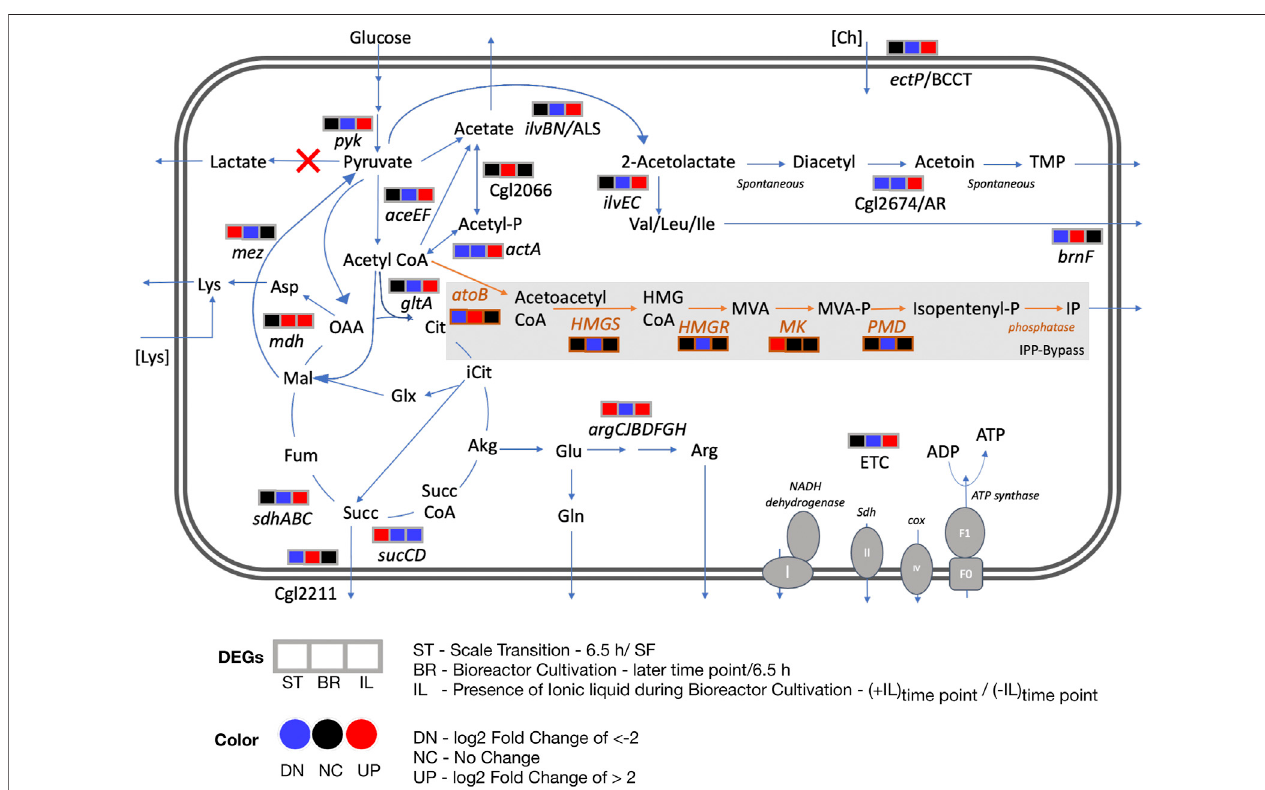
FIGURE 6 | Differential transcript pro fi les of engineered C. glutamicum under fed-batch cultivation. Three DEGs corresponding to three discrete conditions that wereanalyzedarerepresentedhere:ST-scaletransitionfromshake fl ask(SF)toearlybioreactorcultivation(6.5 h),BR-bioreactorlater stagecultivation intheabsence of IL and IL - bioreactor cultivation in the presence of IL compared to in the absence of IL. The heterologous pathway for IP production is shown in orange. Red crosses show the gene deletions in the C. glutamicum strain used in this study. Abbreviations: Acetyl-P, acetyl phosphate; Akg, alpha ketoglutarate; Arg, arginine; Asp, aspartate; atoB , acetyl-CoA acetyltransferase; Cit, citrate; Ch, cholinium; Cox, cytochrome oxidase; ETC, Electron transport chain; Fum, fumarate; Glx, glyoxylate; Glu, glutamate; Gln, glutamine; HMGS , hydroxymethylglutaryl-CoA synthase; HMGR , 3-hydroxy-3-methylglutaryl-CoA reductase; HMG CoA, 3-hydroxy-3-methyl-glutaryl- coenzyme A; Icit, isocitrate; IP, Isopentenol; Lys, lysine; Mal, malate; MK , mevalonate kinase; MVA, mevalonate; MVA-P, mevalonate; OAA, oxaloacetate; PMD, phosphomevalonate decarboxylase; Succ, succinate; Succ CoA, succinyl-CoA; Sdh, succinate dehydrogenase; TMP, tetramethylpyrazine.